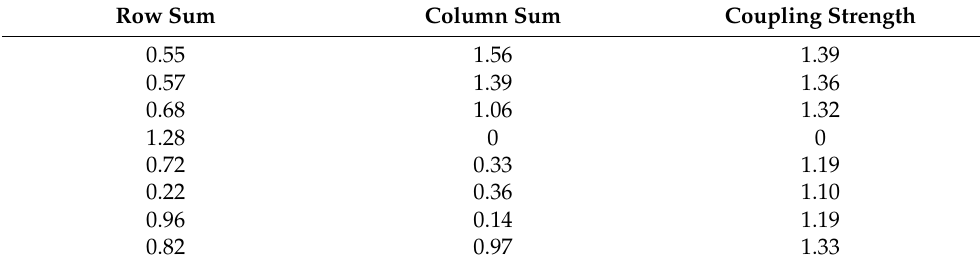
Table 11. The sum of rows, the sum of columns, and coupling strength values of the hazards in the grid G H .